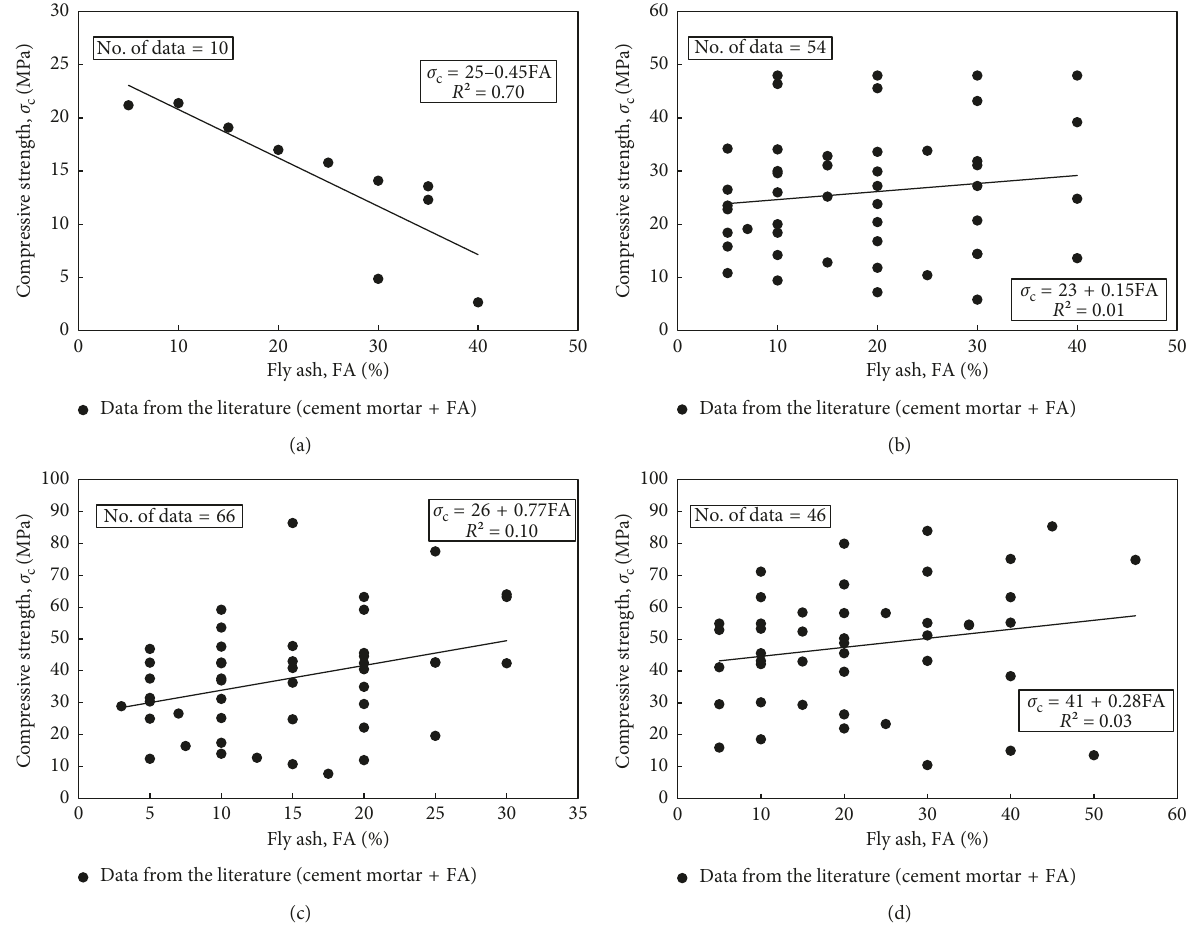
Figure 8: Variation between percentage of fly ash and compressive strength of cement mortar at different curing times: (a) 1day; (b) 7days; (c) 28days; (d) 90days.